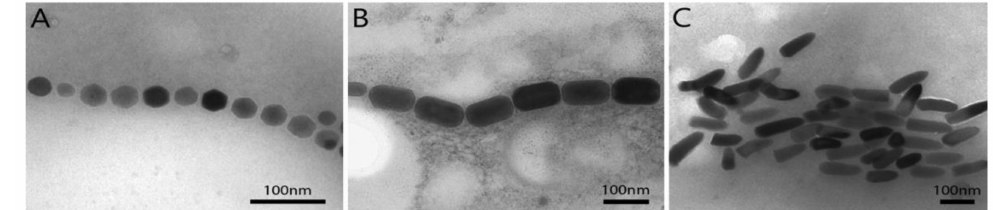
Figure 4. Transmission electron microscopy images of magnetosomes organized in chain(s) within magnetotactic bacteria, showing cuboctahedral ( A ), prismatic ( B ) and bullet-shaped ( C ) magnetite